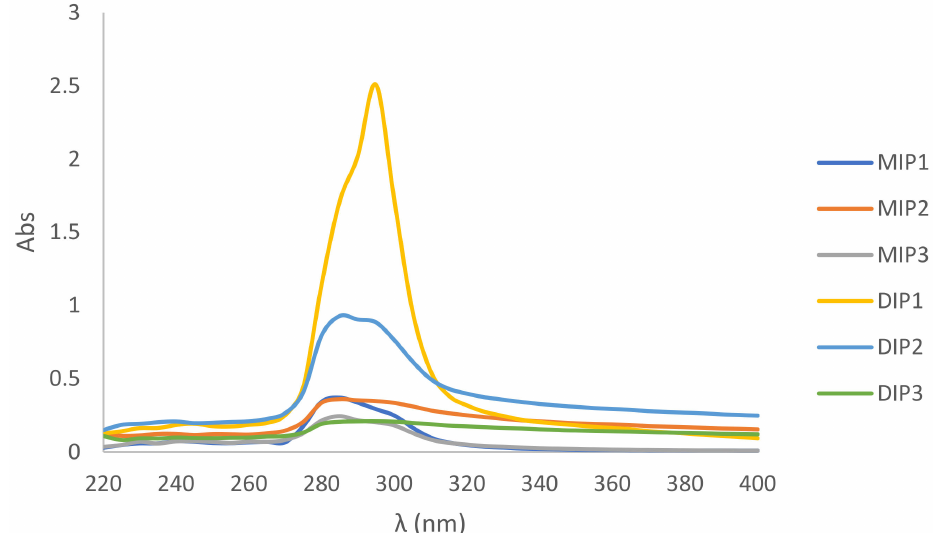
Figure 5. UV–Vis absorption spectra of MIPs and